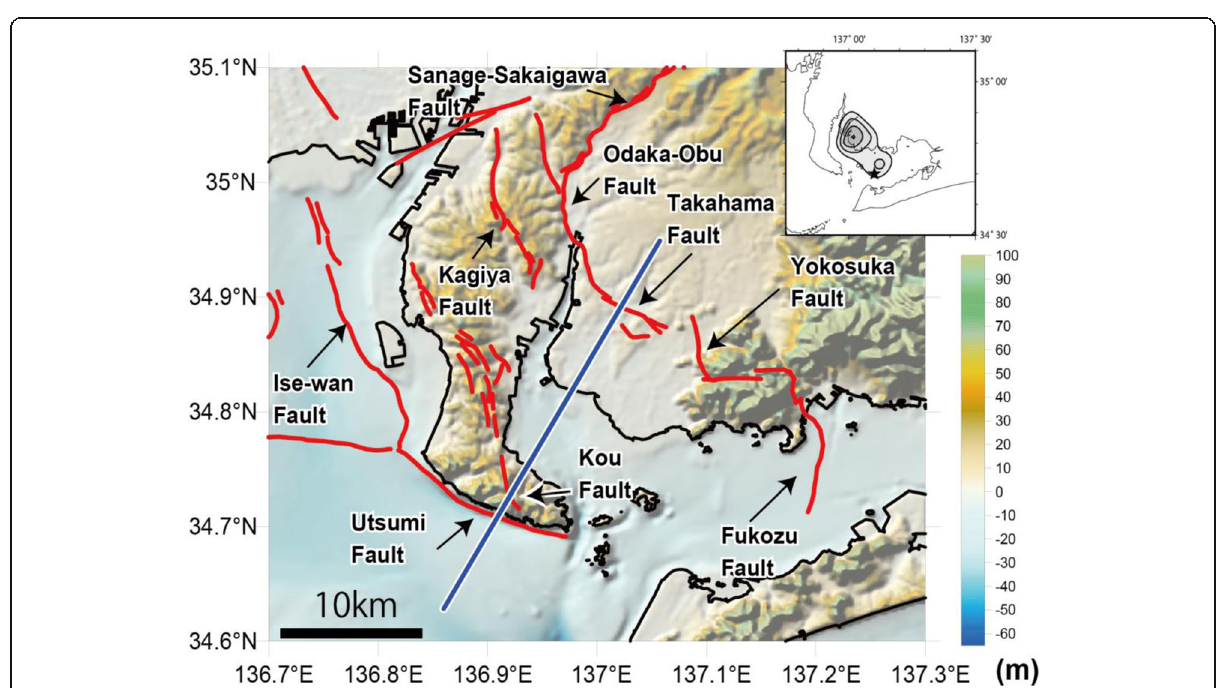
Fig. 2 Topography and active faults in the Mikawa Bay Region. Red lines represent the traces of active faults in Fig. 1b (National Institute of Advanced Industrial Science and Technology, 2020a). The blue line indicates the profile line shown in Figs. 8, 9, and 10. The topography is illustrated using the 30 m gridded terrain data compiled by Murata et al. (2018). The top-right panel represents the slip distribution model of the 1945 Mikawa Earthquake (modified after Kikuchi et al. 2003). The increment of contour lines is 0.5 m and the star indicates the epicenter of the 1945 Mikawa